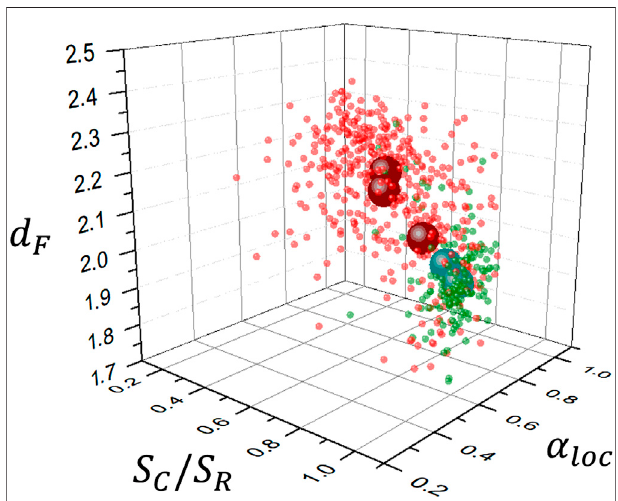
FIGURE 14 | Relevant morphological and scaling parameters used to discriminate between meningiomas and acoustic schwannomas (green) and gliomas (red). Average values are represented as large